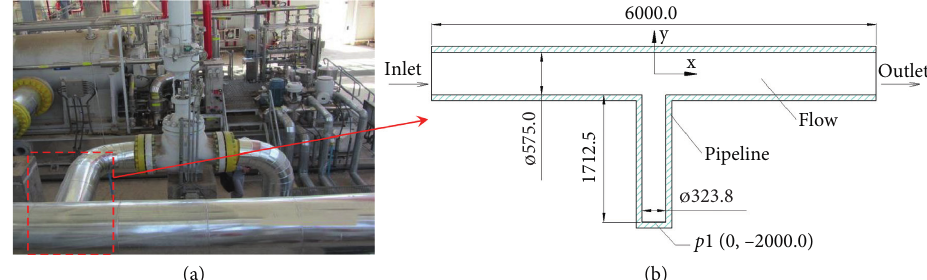
Figure 2: Schematic diagram showing the geometry of the closed side branch of a natural gas pipeline: (a) physical structure of the branch pipe in situ; (b) simplified geometry of the branch pipe (unit: